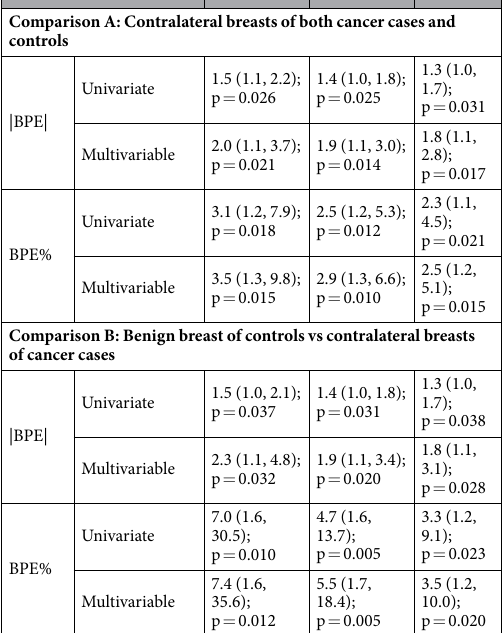
SUBs 1, 2, and 3 combined * P-values